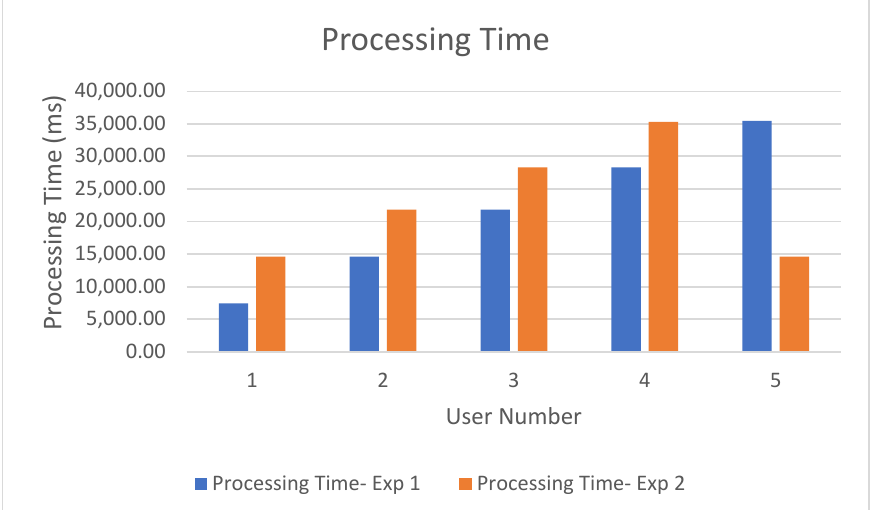
5 Table 6. Sensor 2 Characteristics. Attribute